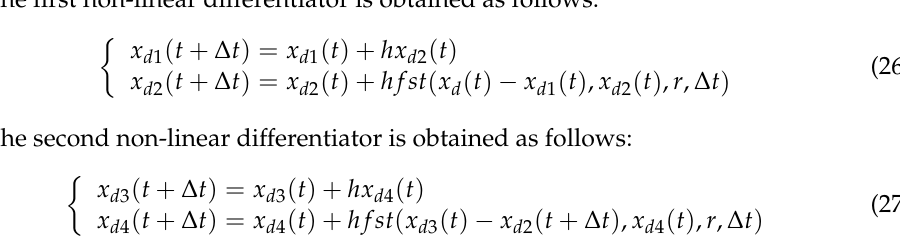
Figure 2. Diagram of the close-loop controller based on NNFTSMC.